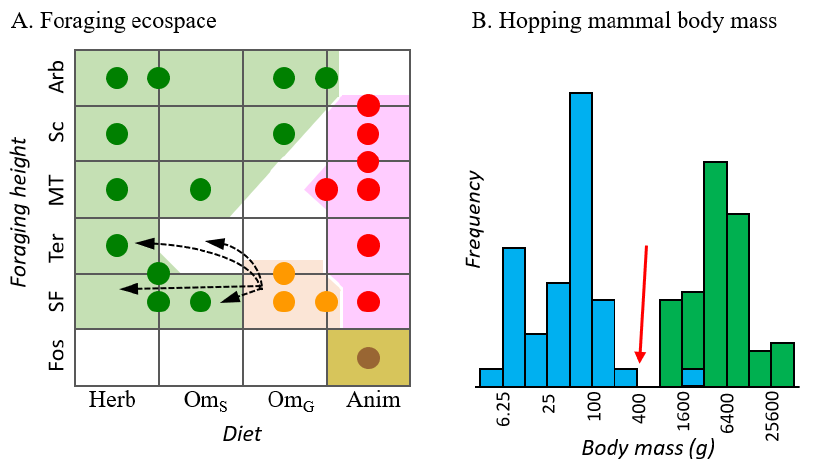
Figure 6. ( A ) Foraging ecospace distribution among extant Australian marsupials, with genera denoted as circles for the four orders, Diprotodontia (green), Peramelemorphia (orange), Notorycte- morphia (brown) and Dasyuromorphia (red). Diet axis: Herb (herbivorous), Om S (plant-specialized omnivorous), OmG (generalized omnivorous), Anim (Animalivory). See Table S6 for definitions and scoring. Foraging height axis: Fos (fossorial), SF (semi-fossorial), Ter (terrestrial), MT (mostly terrestrial), Sc (scansorial) and Arb (arboreal). Dashed arrows indicate four alternative foraging ecospace transitions along the lineage leading to Chaeropus . ( B ) Frequency distribution average adult body mass (g) among all extant hopping mammals, which include rodents (blue) and macropodoids (green). The red arrow indicates estimated body mass for Chaeropus .